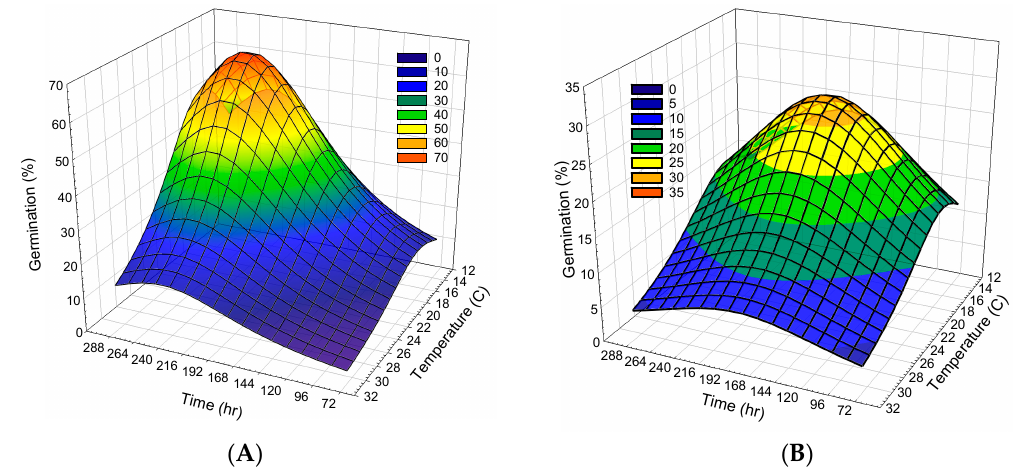
Figure 2. Temperature and time for cumulative ( A ) and maximum ( B ) seed germination using Lorentzian regression for Plantago lanceolata L. using a thermal gradient assay for seed from a Carya illinoinensis grove population in Webster County Georgia. Legend colors, blue hue represents lower germination with green to yellow to red hues indicating increased germination: ( A ) Cumulative germination (%) z